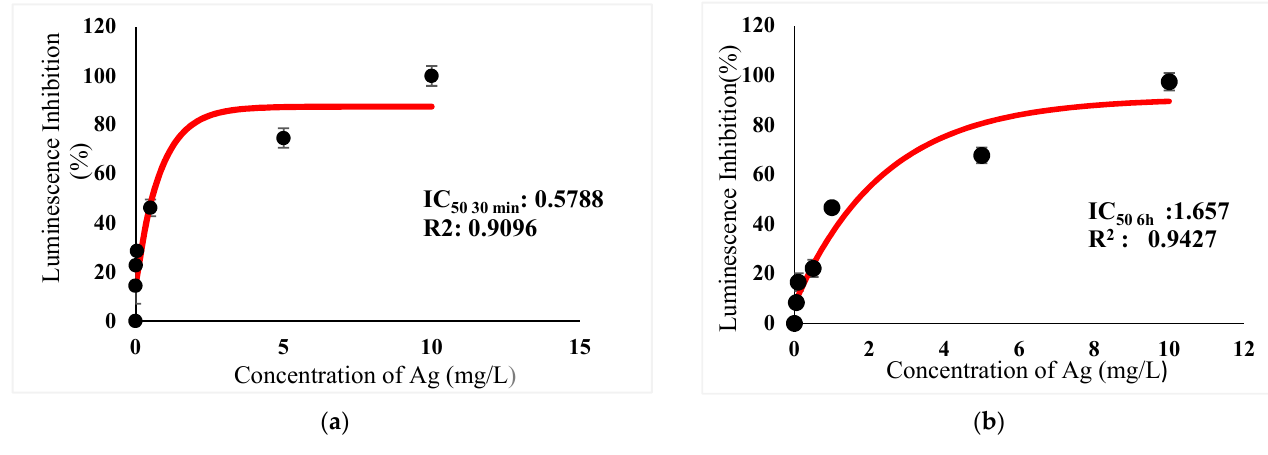
Figure 3. ( a ) Acute and ( b ) Chronic toxicity of Ag 2+ on luminescence inhibition of Photobacterium sp.NAA-MIE. Data represent mean ± SD, n = 3.